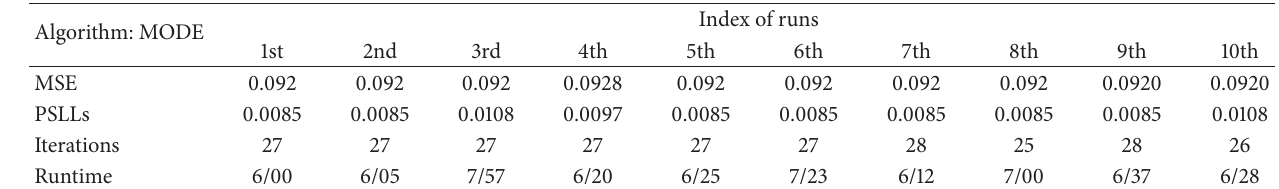
Table 4: Performance of MODE in 10 runs.